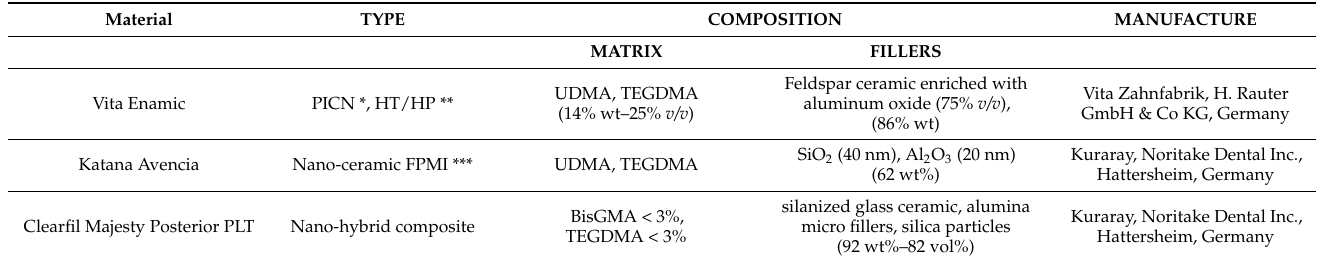
Table 1. Description of materials according to the manufacturer. * PICN = Polymer infiltration ceramic network material FMPI = Filler press and monomer